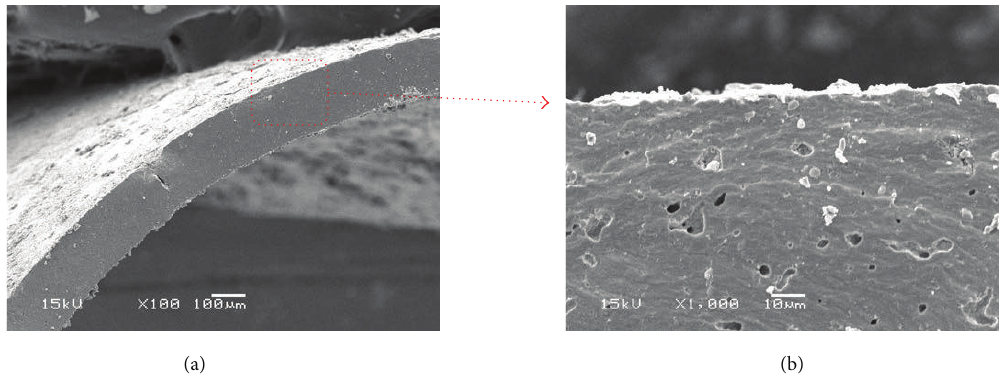
Figure 4: Cross-sectional SEM images of the microtubular LSTF